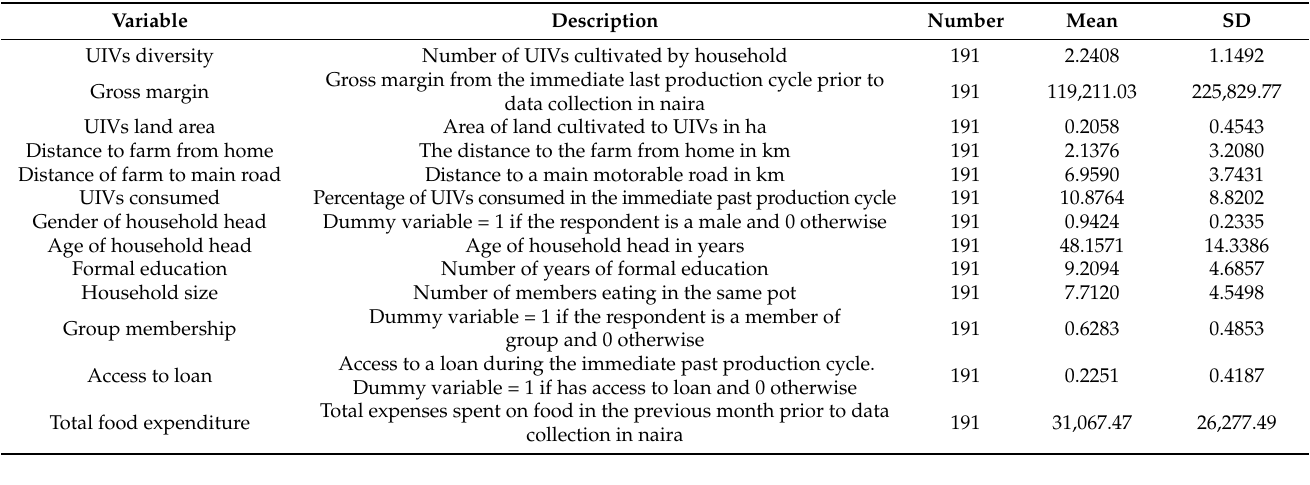
Table 2. Descriptive statistics and variable definitions.